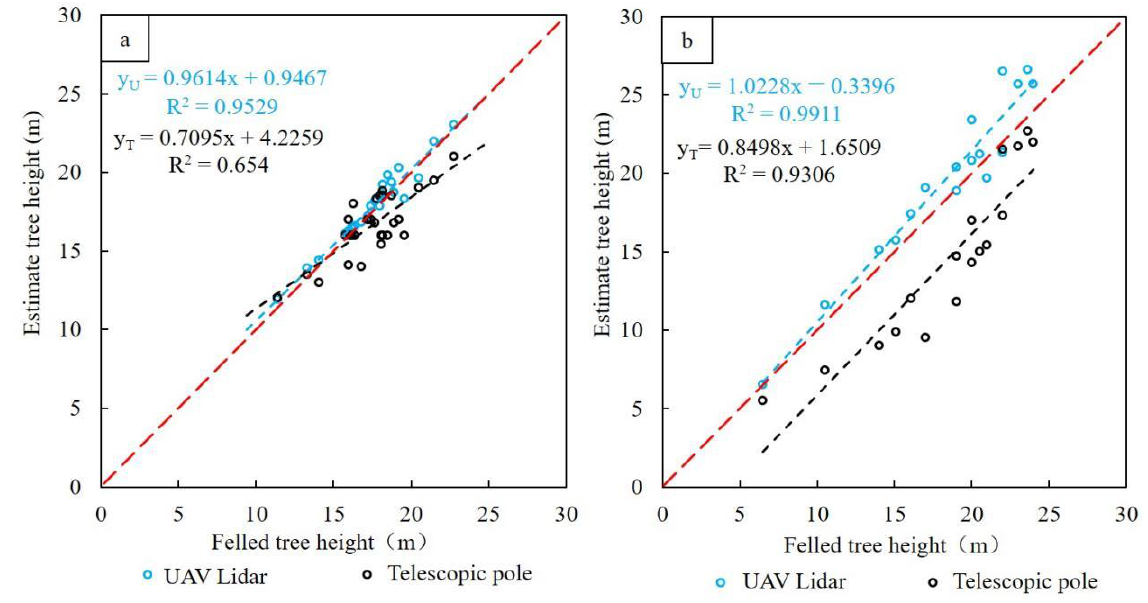
Figure 2. Relationship between reference data and estimated heights using Lidar and a telescopic pole for Masson pine ( a ) and Eucalyptus ( b ).